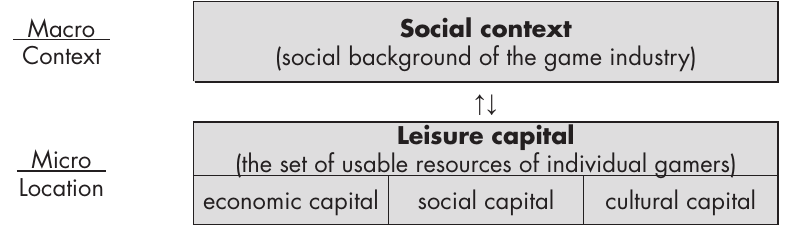
Figure 1 Research framework of leisure capital in the game